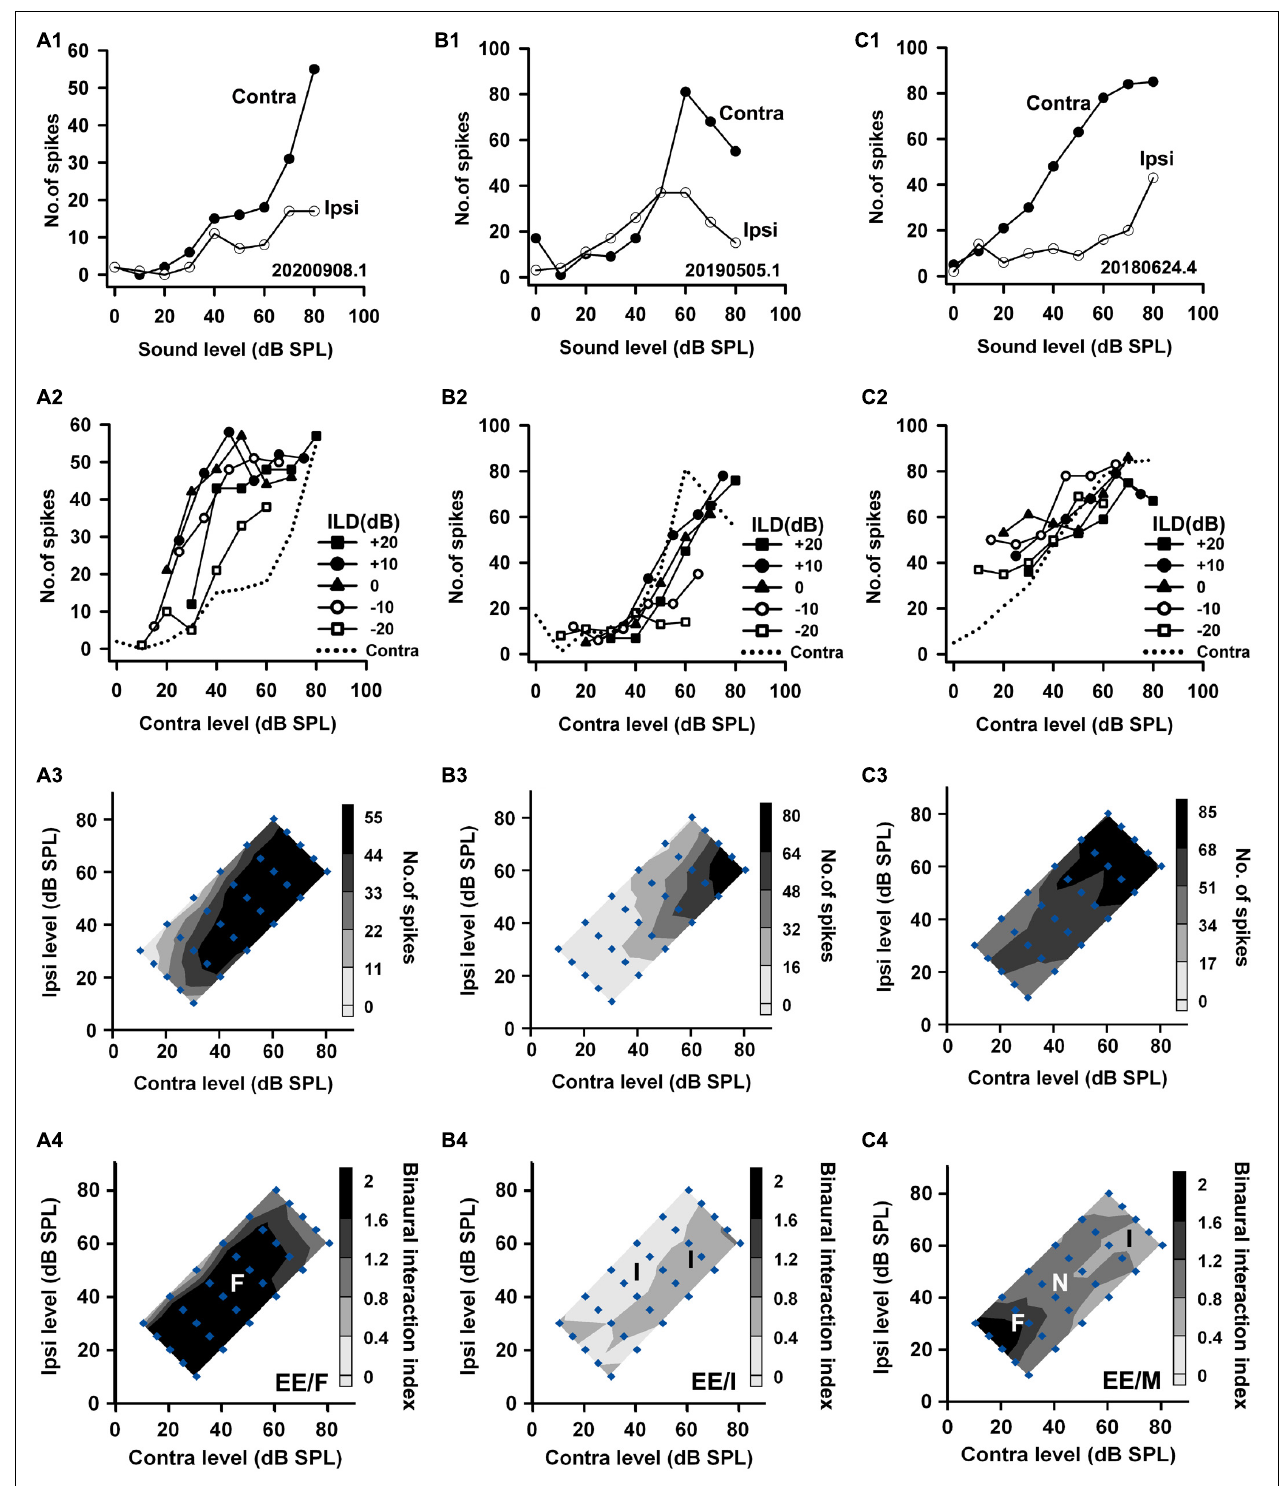
FIGURE 3 | The responses of three EE neurons to both monaural and binaural stimuli. The data shown in each column are from one neuron. The legends for the panels in the four rows are similar to those in Figure 2 . According to monaural responses and the binaural interaction behaviors in the binaural stimulus matrix, the three neurons were categorized as EE/F, EE/I, and EE/M,